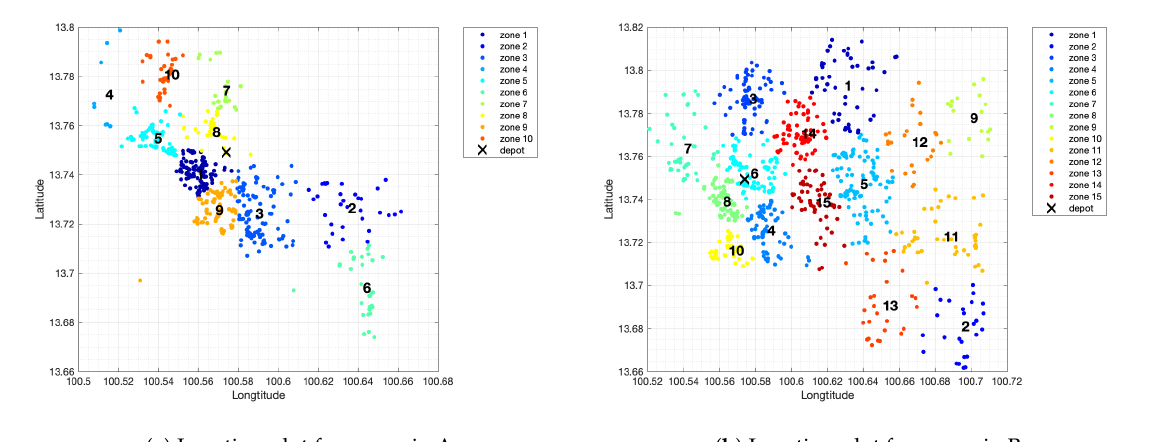
Figure 2. Initial assignment according to the vehicle-zone map of the two real-world scenarios. Scenario A: 609 locations, 10 vehicles; Scenario B: 978 locations, 15 vehicles.